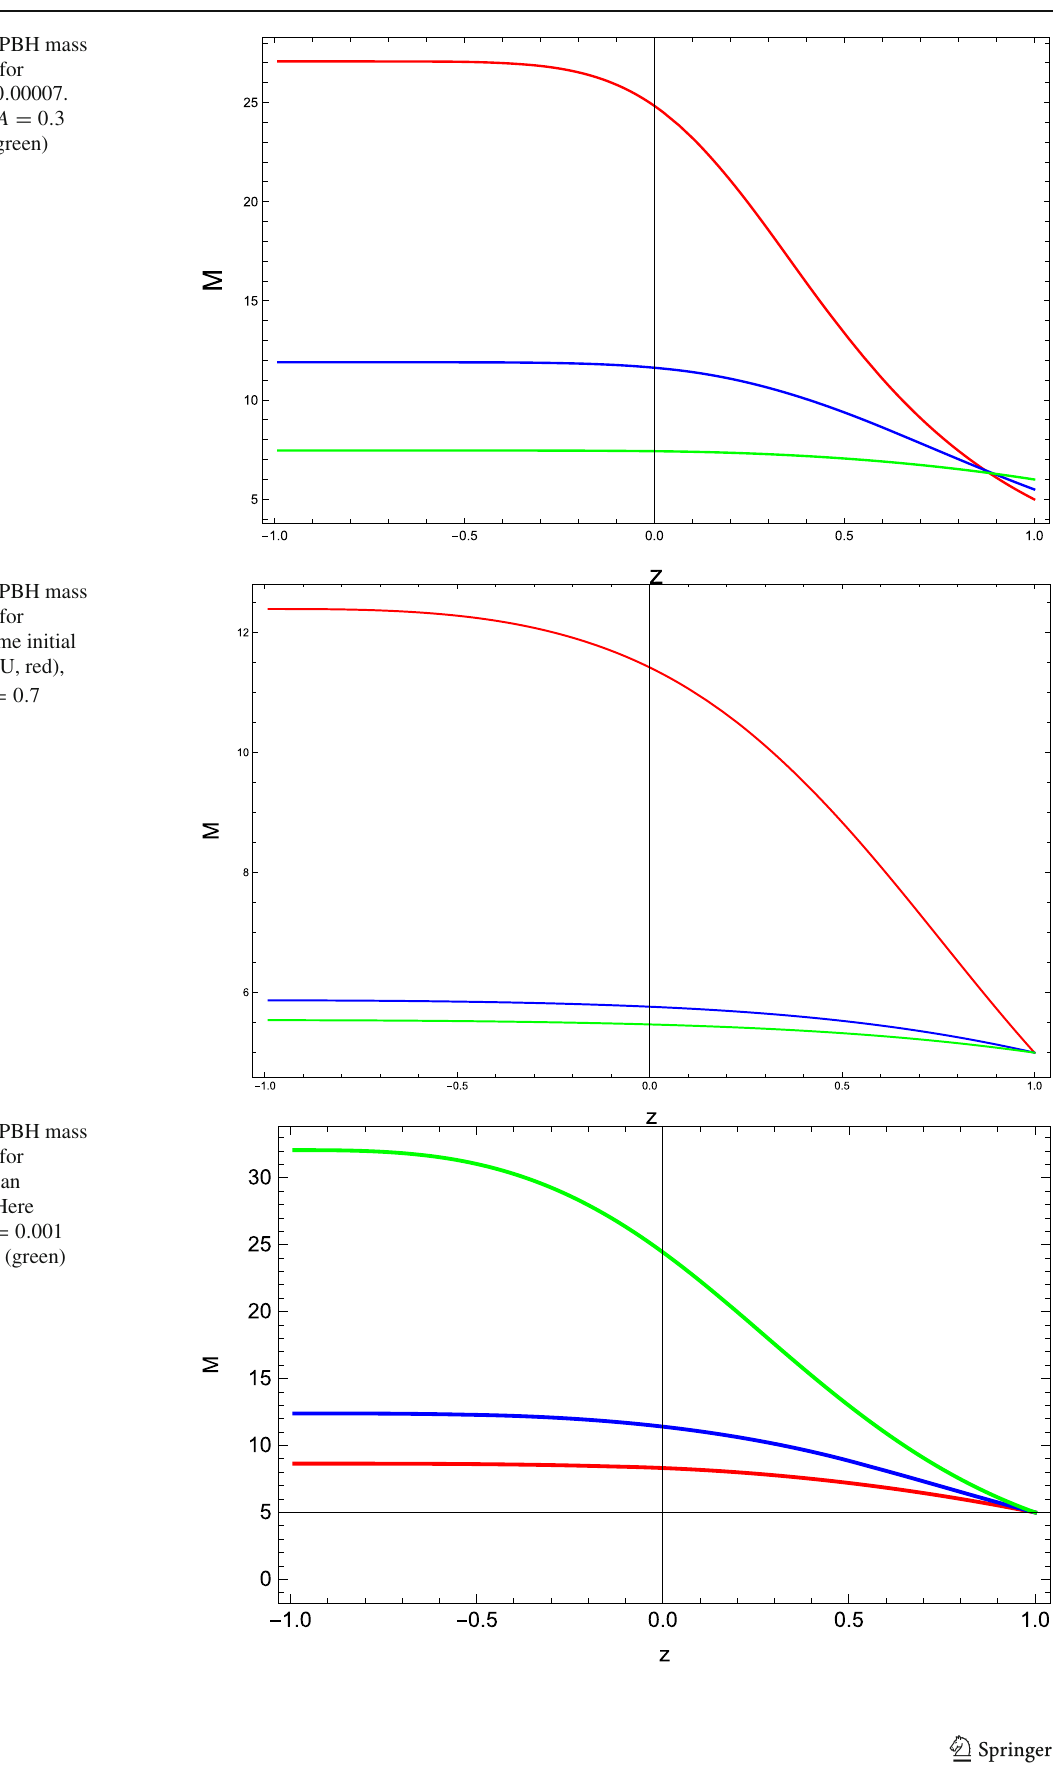
Fig. 5 Evolution of PBH mass M ( z ) with redshift z for different A and λ = 0 . 00007. With A = 0 . 5 (red), A = 0 . 3 (blue) and A = 0 . 1 (green) respectively